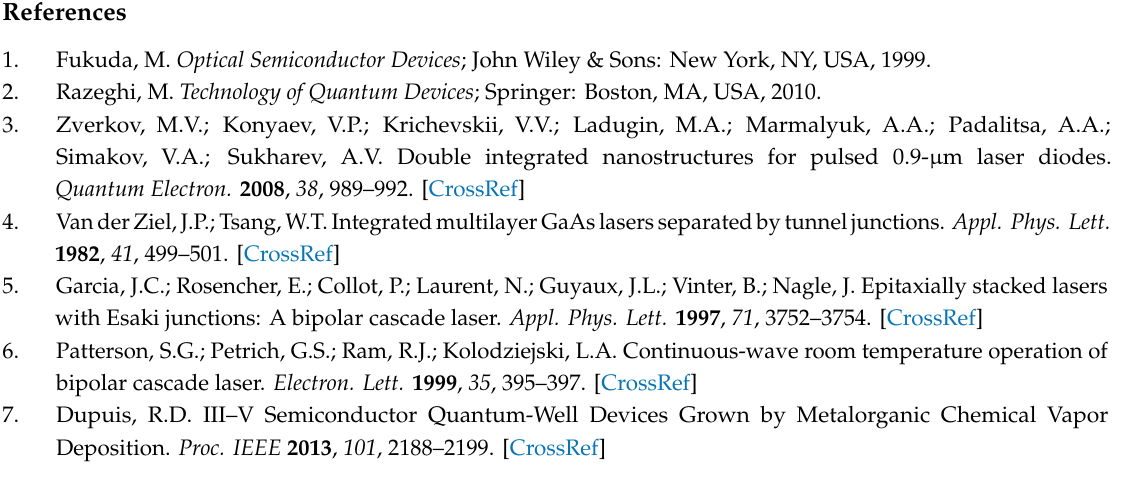
Figure 9. X-ray curve of THz AlGaAs/GaAs QCL heterostructure.